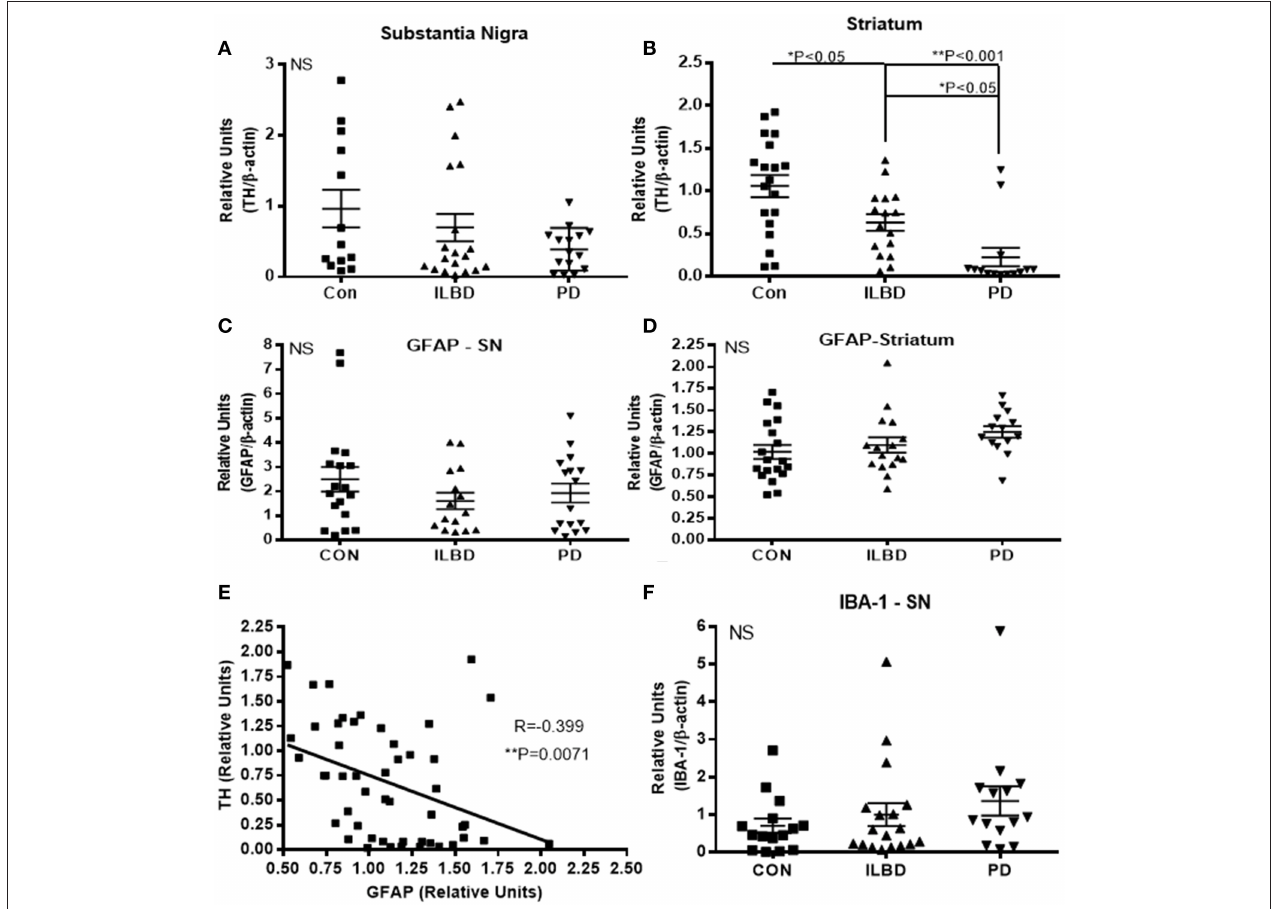
FIGURE 1 | Relative levels of tyrosine hydroxylase, glial fibrillary acidic protein or IBA-1 in substantia nigra. (A,B) Relative levels of tyrosine hydroxylase (TH) in control (Con), incidental Lewy body disease (ILBD), and Parkinson’s disease (PD) samples of SN (A) or striatum (B) determined by western blot measures of TH with normalization for levels of β -actin. Statistical analysis by One-way analysis of variance (ANOVA) with Fisher LSD post-hoc test for between group differences. (C,D) Relative levels of glial fibrillary acidic protein (GFAP) in control (Con), incidental Lewy body disease (ILBD), and Parkinson’s disease (PD) samples of SN (C) or striatum (D) determined by western blot measures of GFAP with normalization for levels of β -actin. Statistical analysis by One-way analysis of variance (ANOVA) showed no significance between disease groups. (E) Linear regression plot showing relation between striatum TH and striatum GFAP levels. Pearson correlation analysis showed significance between these measures ( R = − 0.399 , P = 0.0071 ). (F) Relative levels of IBA-1 in control (Con), incidental Lewy body disease (ILBD), and Parkinson’s disease (PD) samples of SN determined by western blot measures of with normalization for levels of β -actin. Statistical analysis by One-way analysis of variance (ANOVA) showed no significant difference between disease